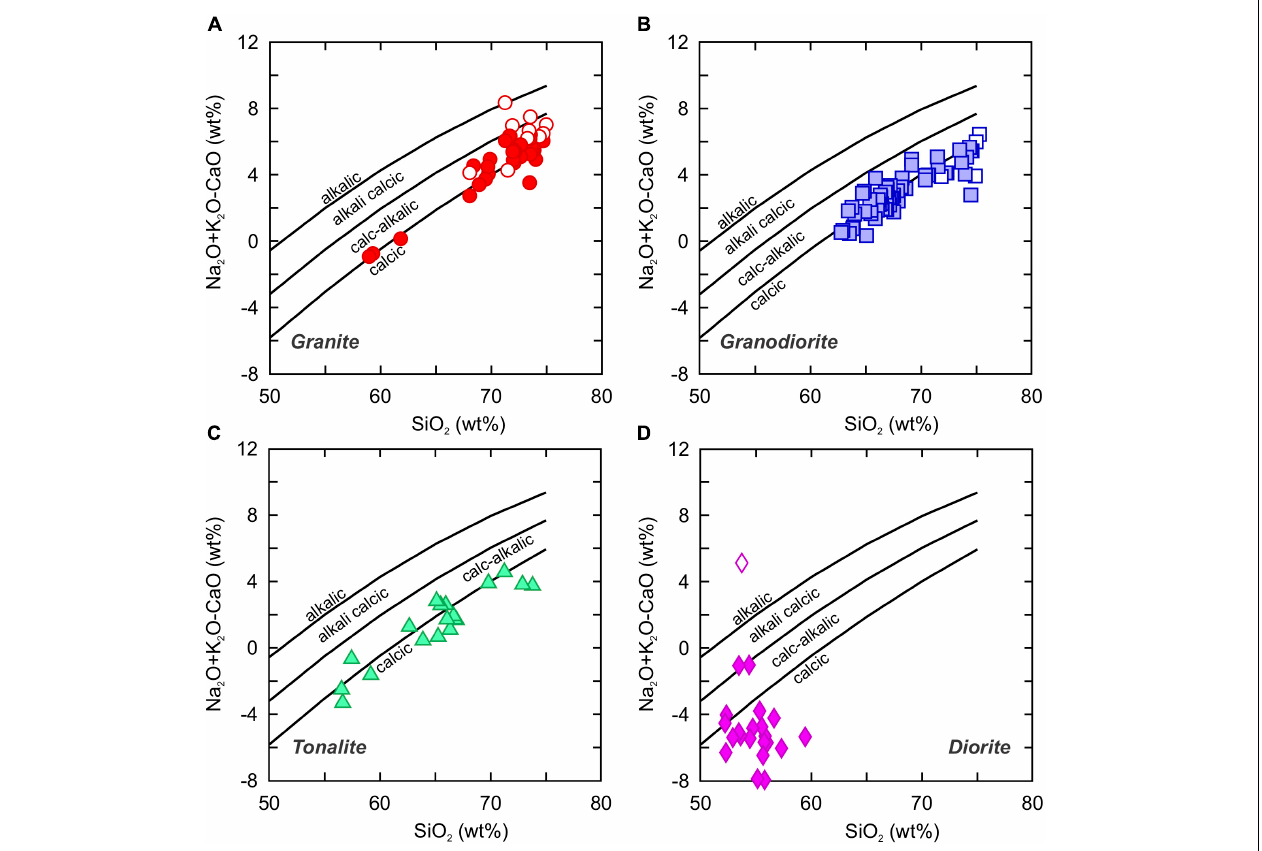
FIGURE 3 | Modified alkali-lime index (Na 2 O + K 2 O − CaO wt%) vs. SiO 2 (wt%) of the Cretaceous (A) granites, (B) granodiorites, (C) tonalites, and (D) diorites from Kyushu (Frost et al., 2001). Symbols as in Figure 2 .